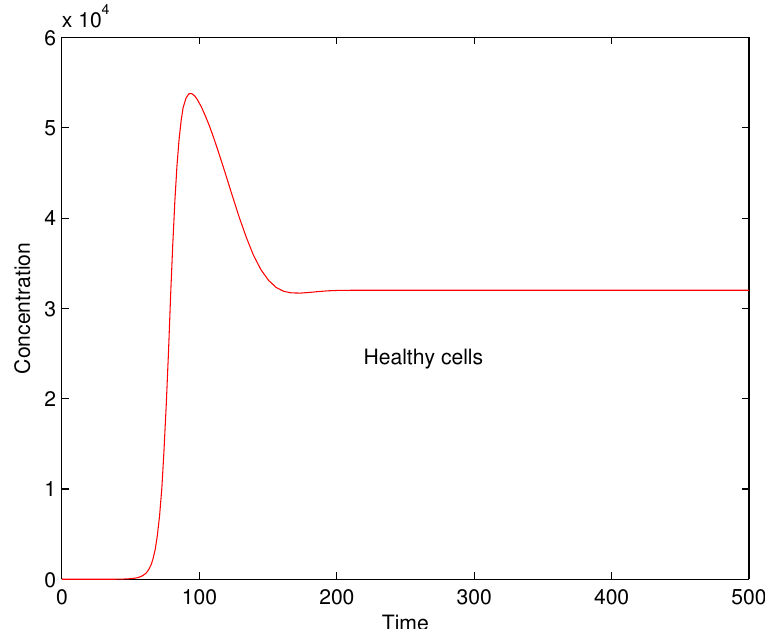
Figure 3. Concentrations of healthy cells for p id = 0.00010.